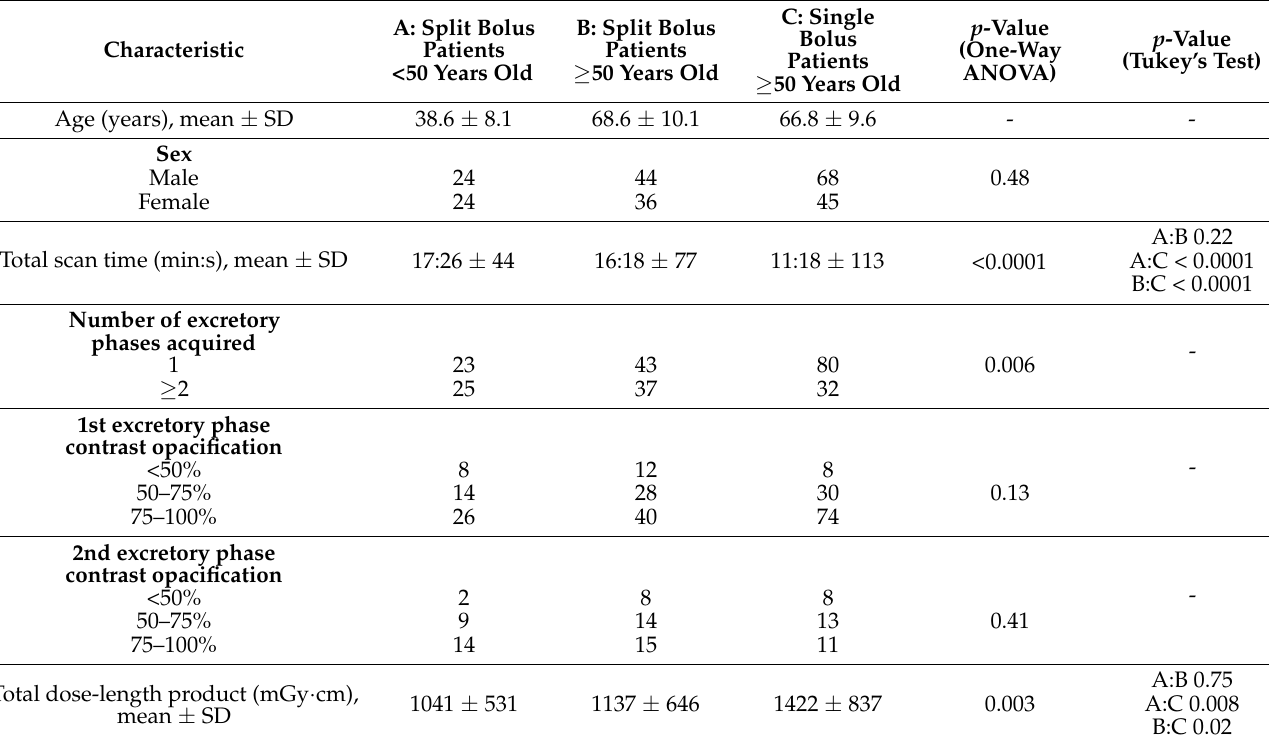
Figure 1. Study patient flowchart. Table 1. Summary of patient and CT Urography characteristics for each patient group.